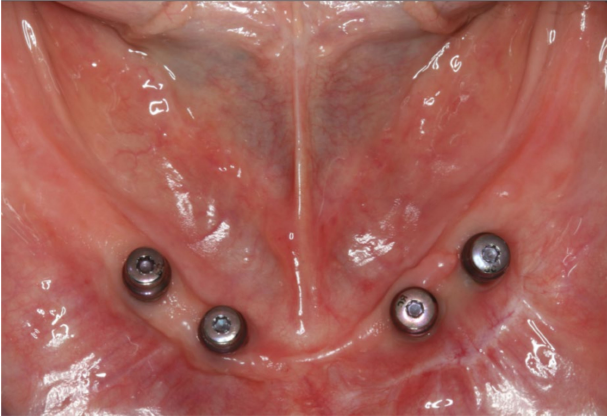
Figure 3. Intraoral photograph of the lower jaw with four interforaminal implants supplied with healing